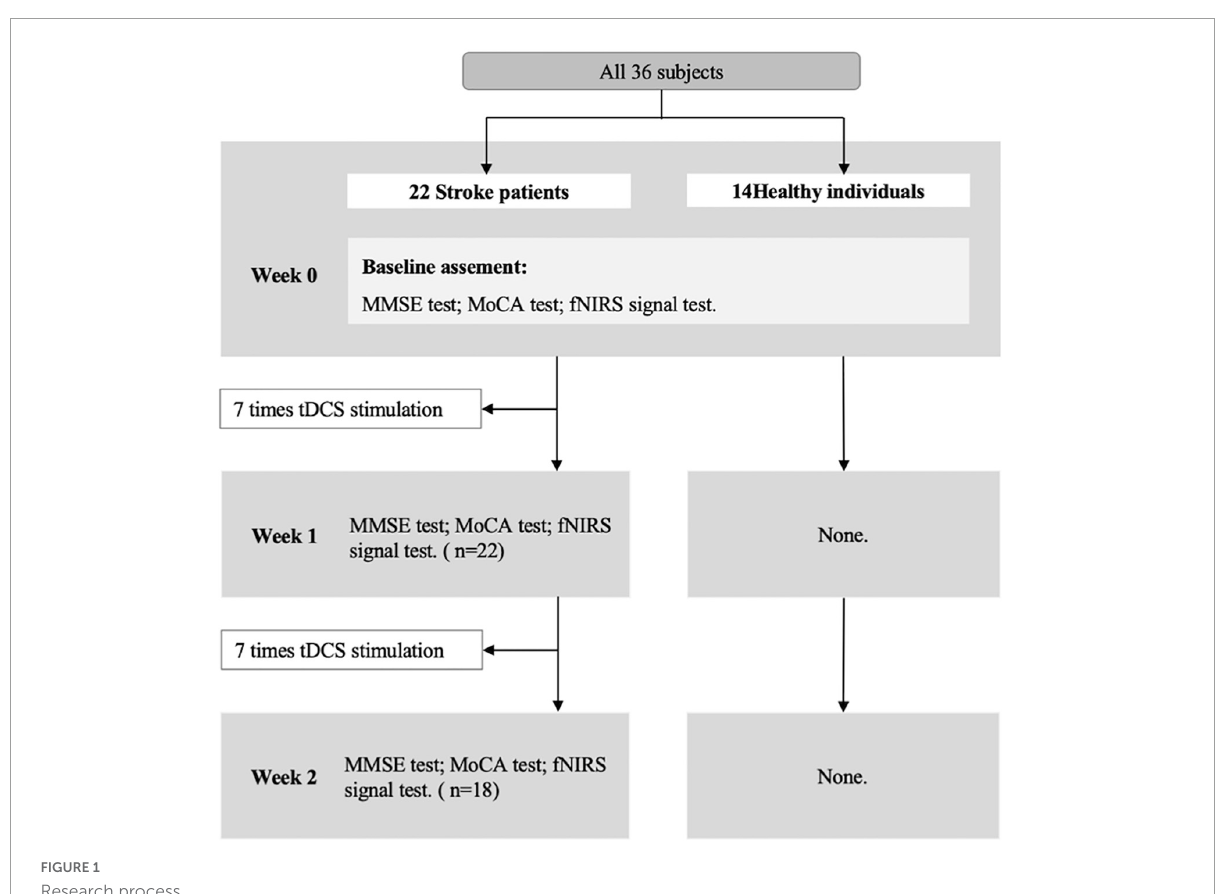
FIGURE1 Research